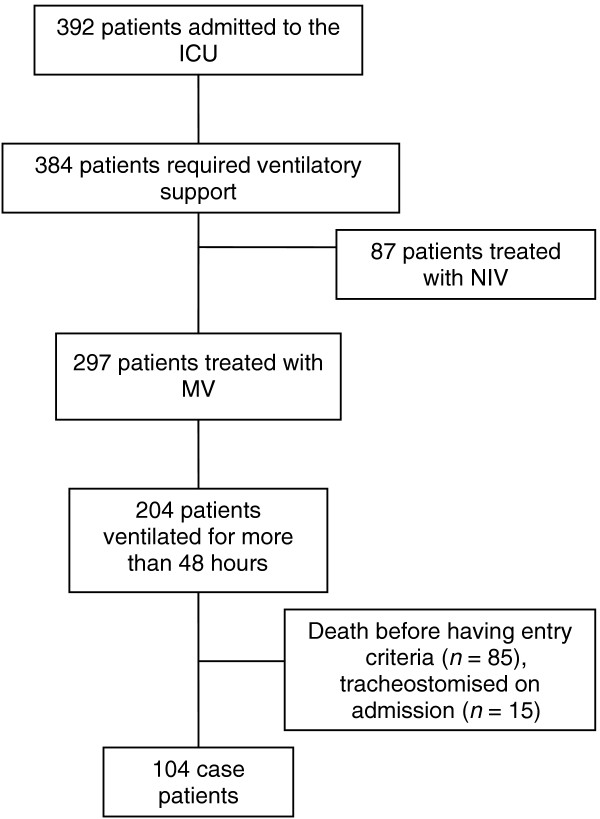
Case selection. ICU, intensive care unit; NIV, noninvasive ventilation.